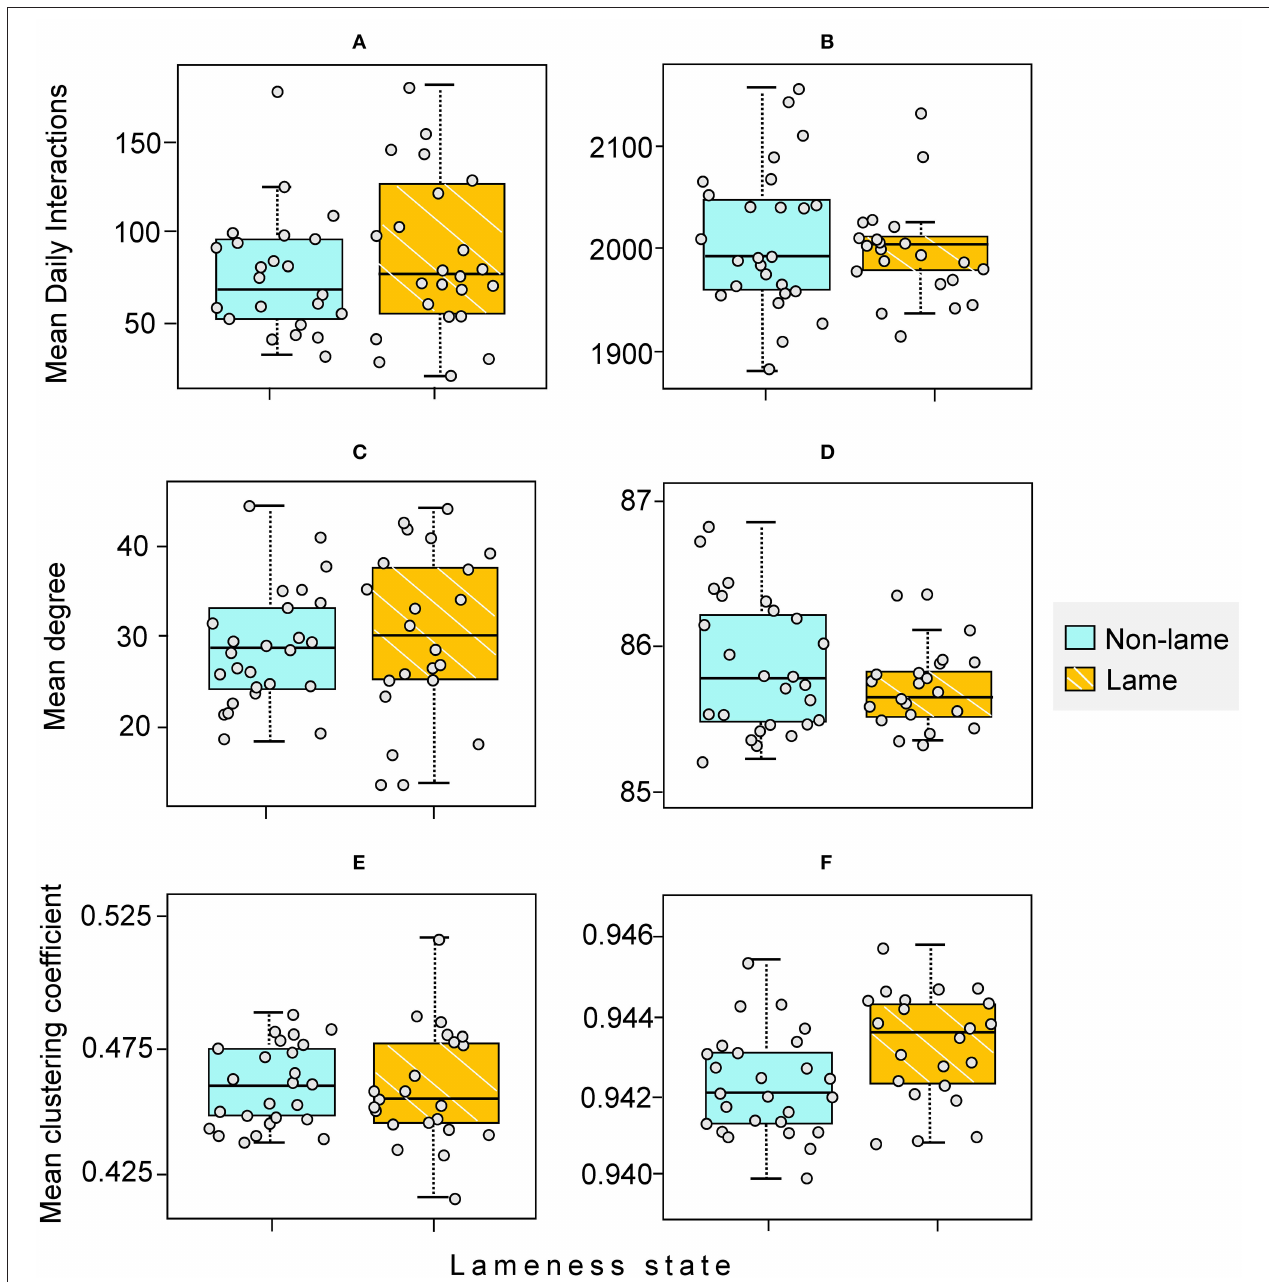
FIGURE 6 | Comparison of Mean Daily Interactions and node-level measures (degree and clustering coefficient) between non-lame (NL) ( n = 26) and lame (L) ( n = 22) cows. (A,C,E) feeding zone; (B,D,F) non-feeding zone. The horizontal line in each boxplot represents the median value. The mean [standard deviation] values for NL and L cows are given, respectively by: (A) 74 [35] and 90 [44]; (B) 2015 [70] and 2006 [45]; (C) 27.92 [8.53] and 30.14 [9.37]; (D) 85.85 [0.45] and 85.68 [0.26]; (E) 0.44 [0.09] and 0.46 [0.02]; (F) 0.94 [0.001] and 0.94 [0.001]. Each individual cow is indicated with a small